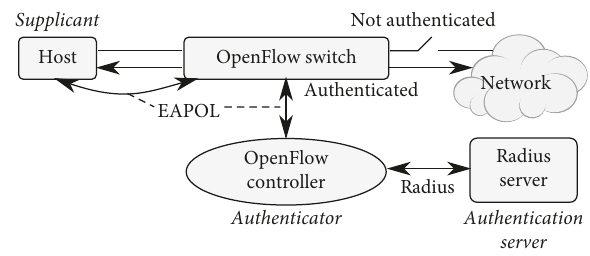
Figure 6: EAP/RADIUS authentication using